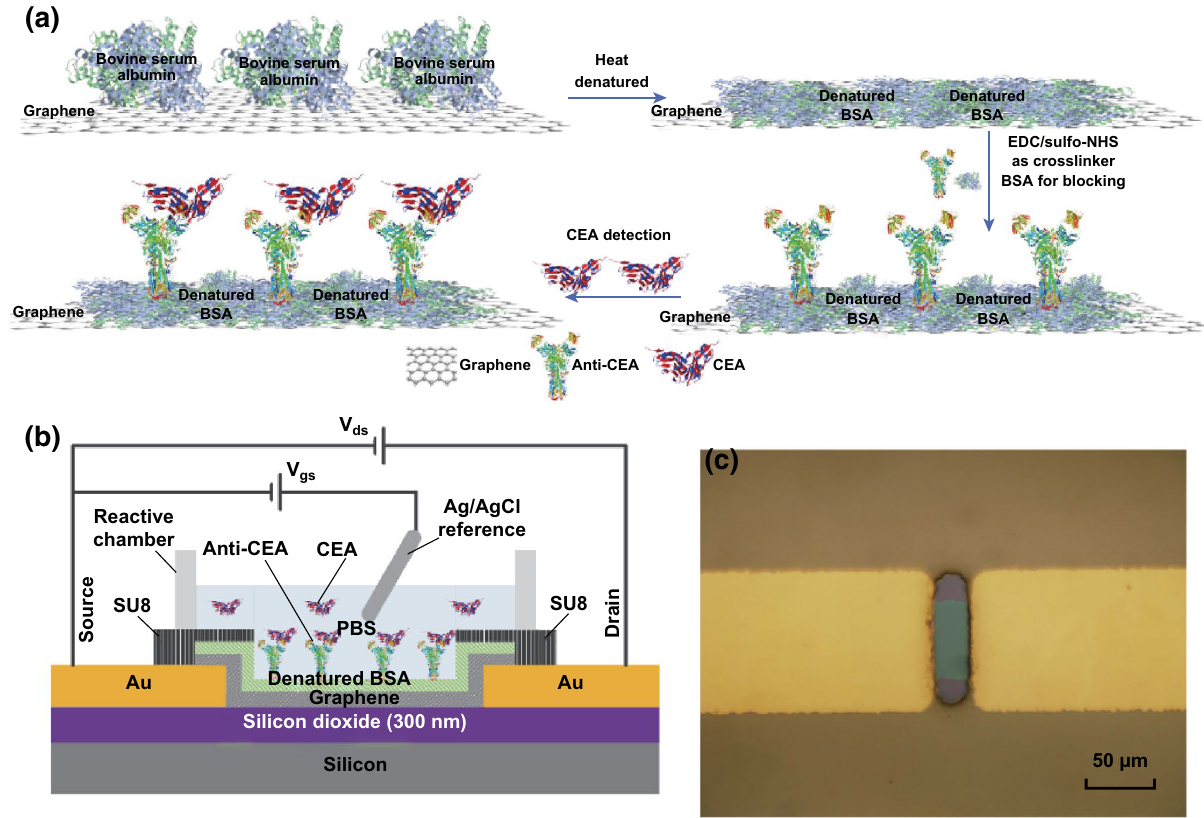
Fig. 2 a Processes of the modification for anti‑CEA‑dBSA functionalized graphene. b Schematic diagram of electrolyte‑gated anti‑CEA‑dBSA functionalized GFET. c Optical micrograph of the graphene